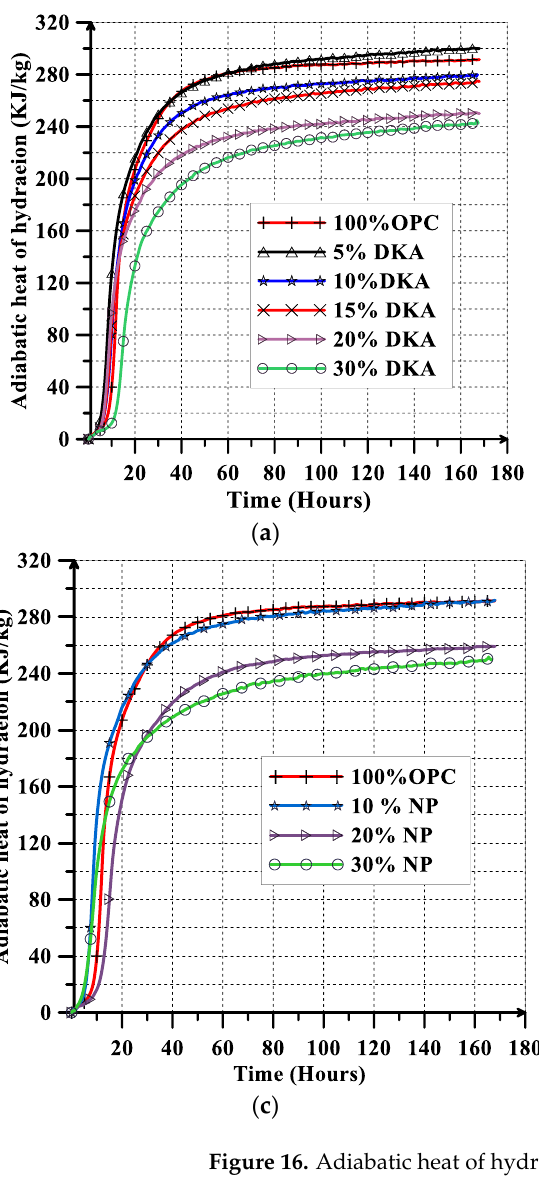
Q.W QW cm cm ATR = ATR = γ c .c